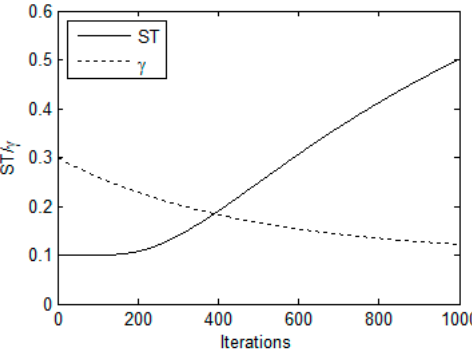
γ over iterations. Figure 6. Variations of ST and γ over